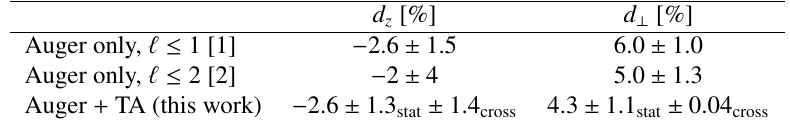
Table 2. Constraints on the UHECR dipolar component along the Earth rotation axis, d z , and along the perpendicular plane, d ⊥